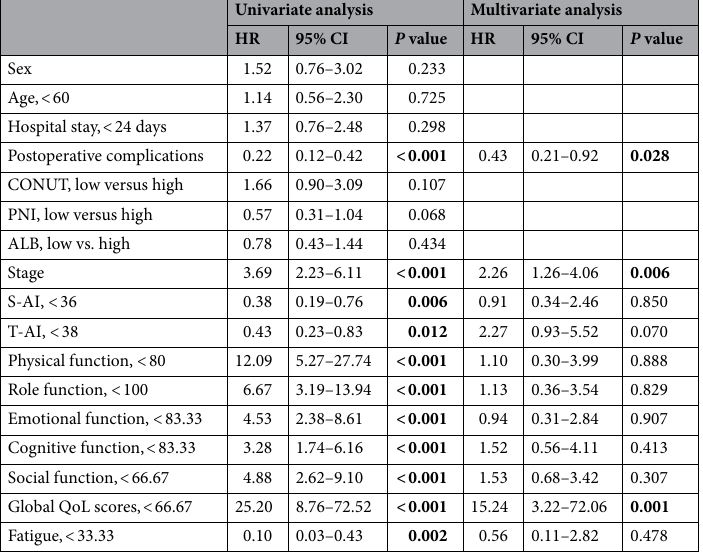
Table 14. Results of univariate and multivariate analyses of factors associated with overall survival in gastric cancer patients with